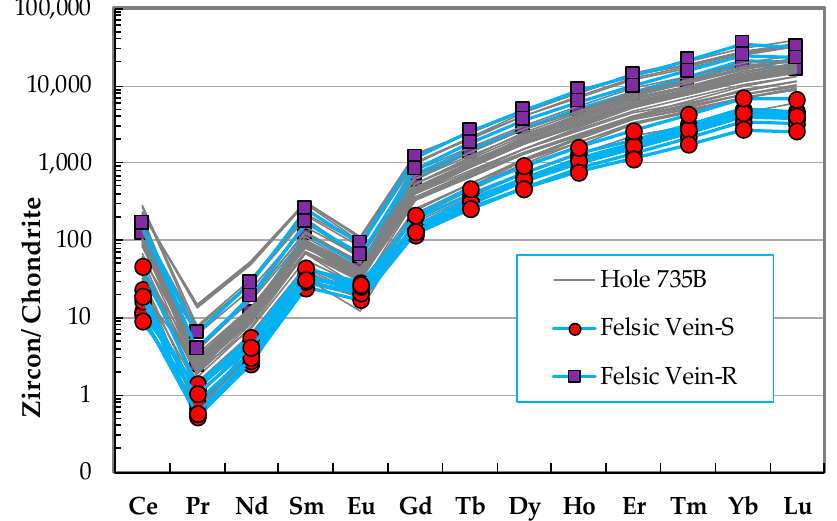
Figure 17. Chondrite-normalized rare earth element abundances of zircon in felsic veins, from IODP Hole U1473A and a comparison with those of ODP Hole 735B, Sections 3 and 4 including 42 zircon analyses; data from Reference [12]. Chondrite values are from Reference [37].